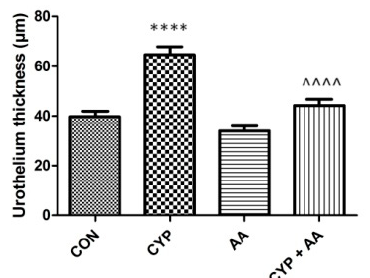
Figure 5. The effects of pretreatment with asiatic acid (30 mg/kg/day for 14 days by oral gavage) on cyclophosphamide (CYP, 200 mg/kg, i.p., single dose) induced changes in urothelium thickness. All results are presented as the mean ± SEM (n = 15 rats per group). The obtained data was assessed by the one-way ANOVA followed by Tukey’s post hoc test. * when significantly different from the control group. ˆ when significantly different from the CYP group. **** or ˆˆˆˆ p < 0.0001. One-way ANOVA for urothelium thickness: F(3.56) = 29, p < 0.0001. AA: asiatic acid; CON: control; CYP: cyclophosphamide.